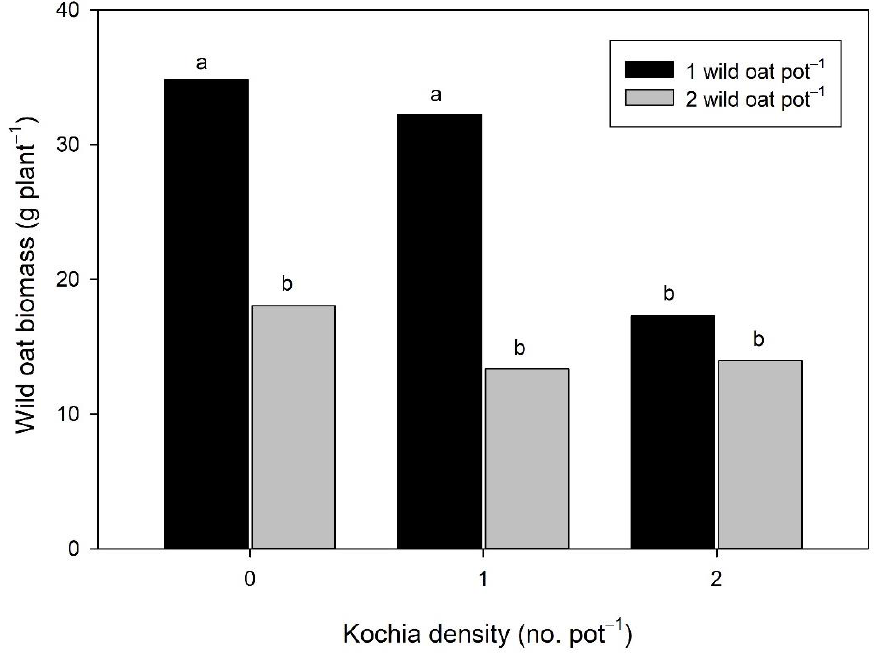
Figure 5. Wild oat ( Avena fatua ) biomass for the first experimental run as impacted by kochia ( Kochia scoparia ) and wild oat densities when grown in a greenhouse in Saskatoon, SK in 2019. Plants were grown in 13 cm diameter round pots filled with potting soil. Biomass was taken at 81 days after trial initiation. Values are least square means. Different letter groups indicate a significant difference using Tukey’s honest significance test ( p = 0.05).